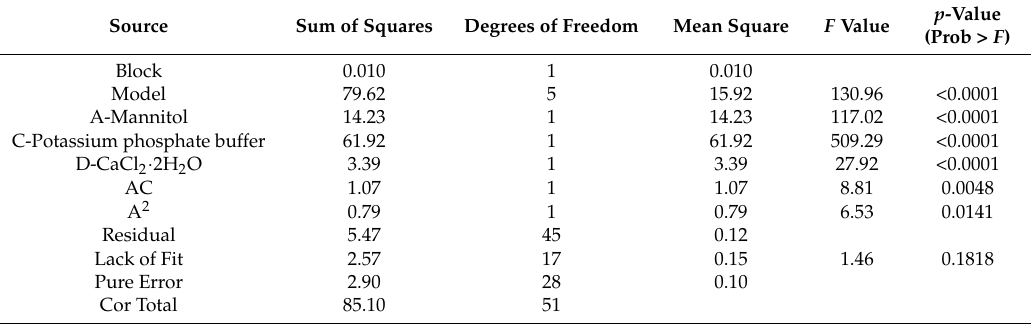
Table 7. ANOVA for the regression model of biomass production obtained from CCD results. Source Sum of Squares Degrees of